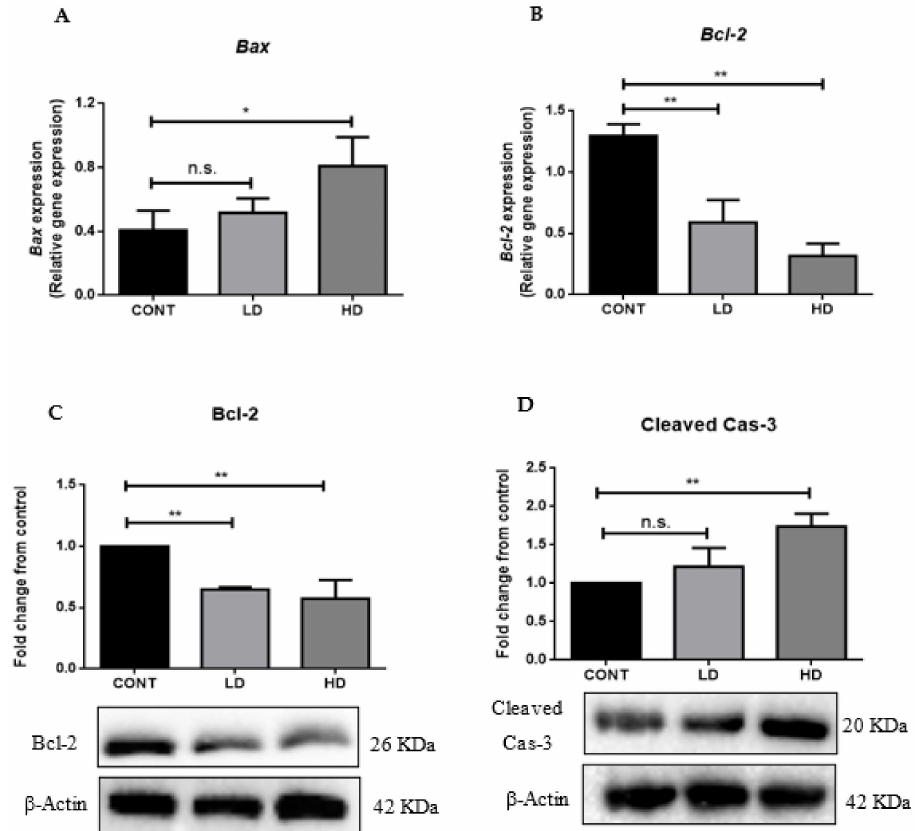
Figure 4. VTX-induced apoptosis in the heart. The mRNA levels of Bax ( A ) and Bcl-2 ( B ) were mea- sured using RT-PCR. Data were normalized to β -actin as a housekeeping gene and one-way analysis of variance (ANOVA), followed by Tukey–Kramer multiple-comparisons tests. ( C ) Representative Western blot analysis of Bcl-2 protein levels. ( D ) Representative Western blot analysis of Cleaved Cas-3 protein levels. Data are presented as mean ± SD ( n = 5). * p < 0.05, ** p < 0.01; n.s., no significant changes were observed ( p > 0.05). Cont, control; LD, low-dose venetoclax (50 mg/kg); HD, high-dose venetoclax (100 mg/kg); Bax, Bcl-2 associated X; Bcl-2, B-cell lymphoma 2; Cleaved Cas-3, cystinyl aspartate-specific proteases 3; β -actin, beta